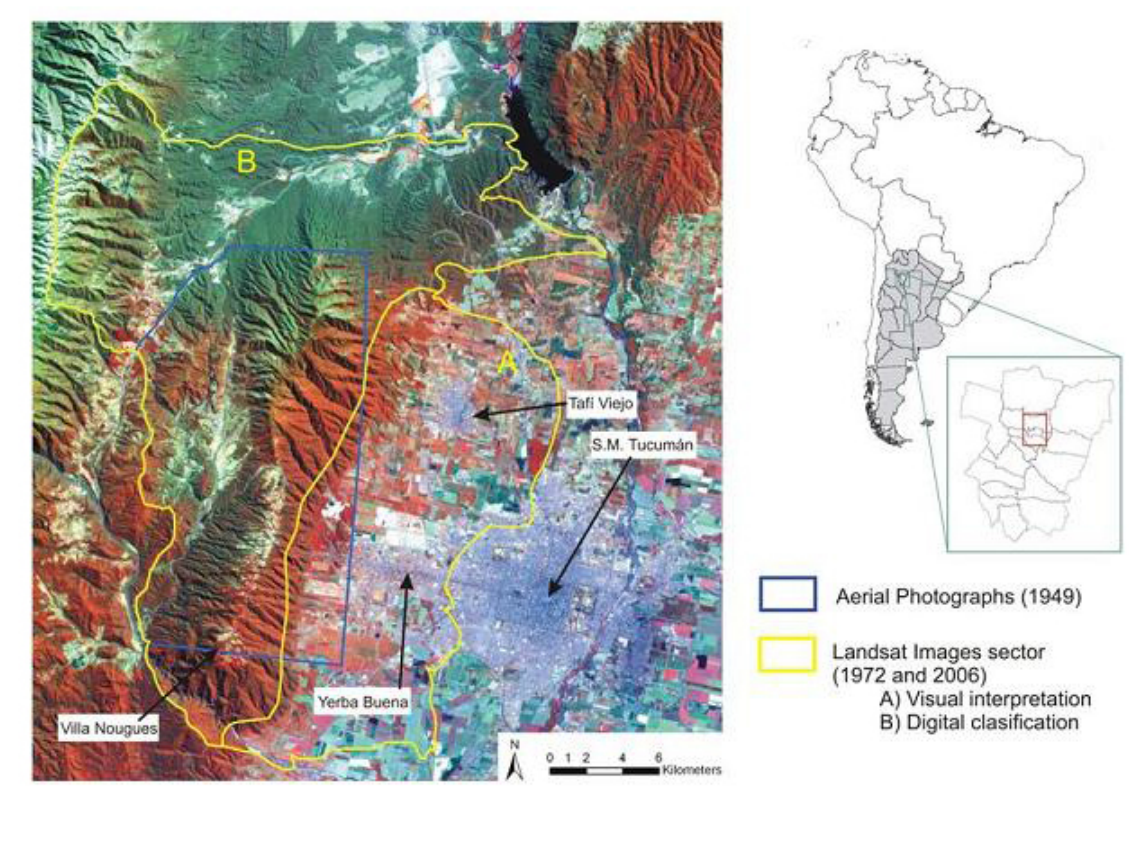
Fig. 1. Study area indicating location in South America and Argentina, main urban centers, and zonation of different types of analyses. (A) indicates the sector classified using on-screen visual digitalization, and (B) indicates the sector classified using spectral